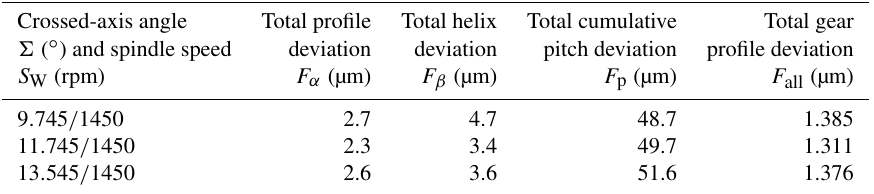
Table 8. The gear profile error results of IGPH experiments without the active control